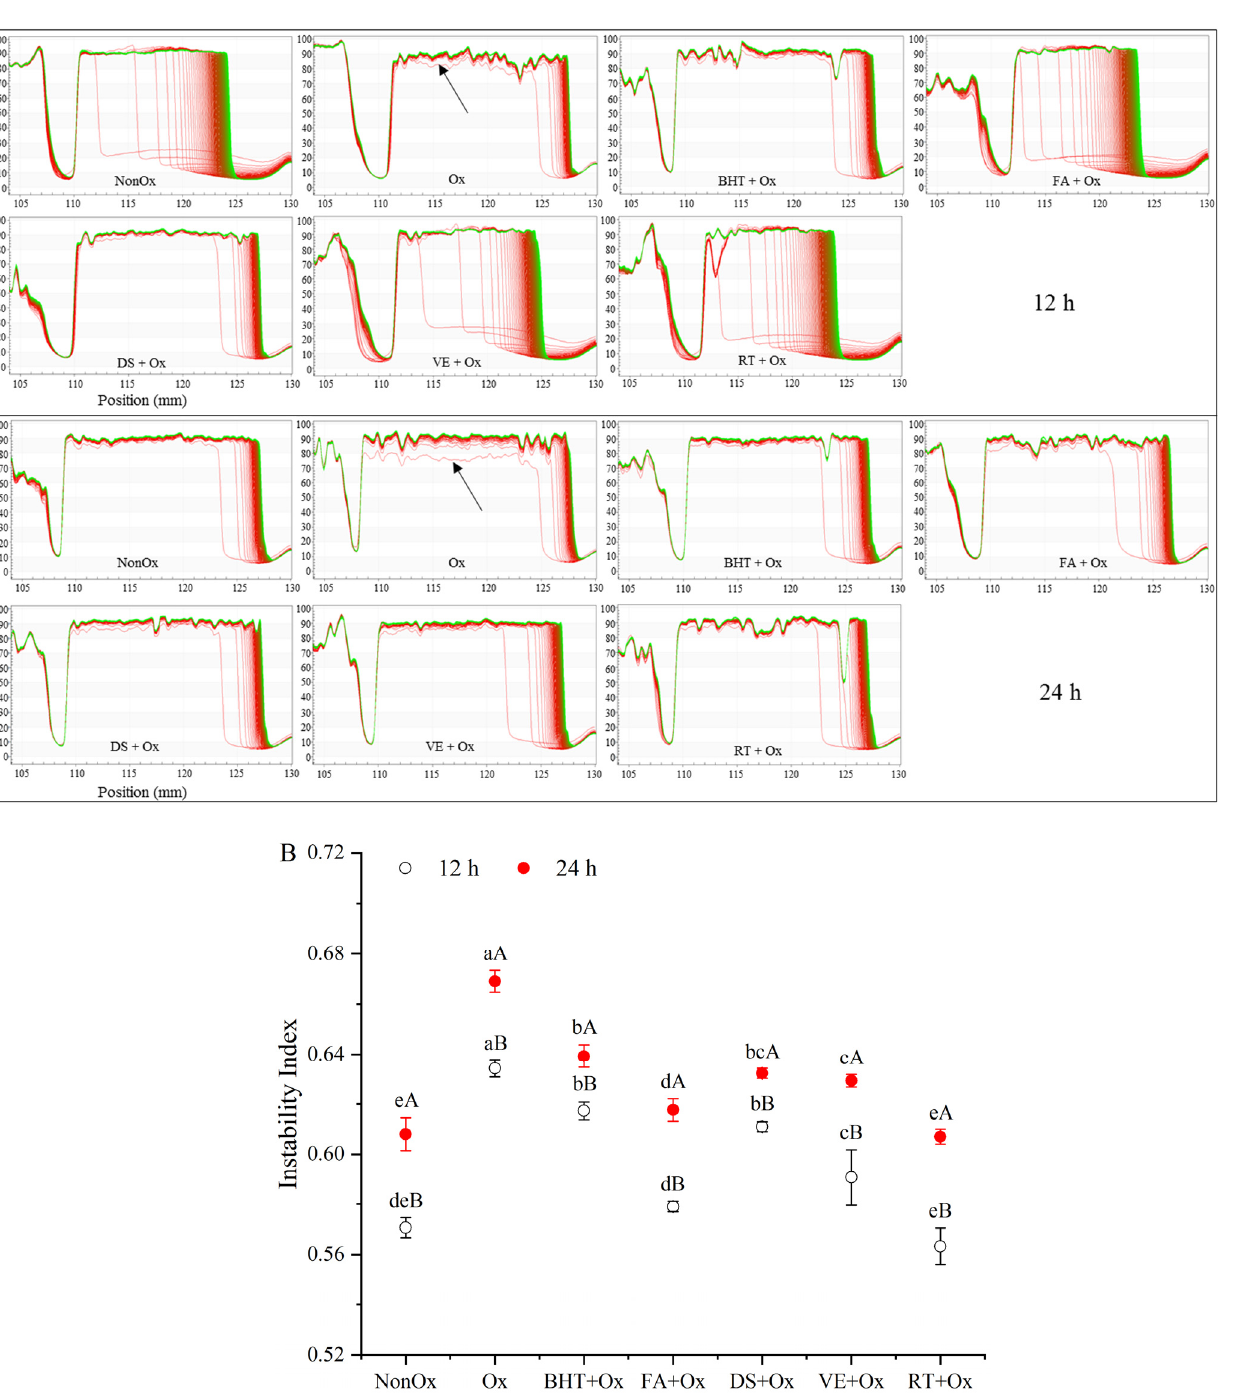
Figure 6. Physical stability profiles (original transmission) ( A ) and instability index ( B ) of MPs analyzed by LUMISizer at 12 h and 24 h in minced yak meat supplemented with different antioxidants. Note: NonOx—non-oxidized; Ox—oxidized without antioxidant; BHT + Ox, FA + Ox, DS + Ox, VE + Ox, and RT + Ox—oxidized in the presence of BHT, ferulic acid, diallyl sulfide, α -tocopherol, and rutin, respectively. a–e Means with different lowercase letters are significantly different among antioxidant treatments for the same oxidation time ( p < 0.05); A–B Means with different uppercase letters are significantly different between 12 and 24 h for the same antioxidant treatment ( p < 0.05).